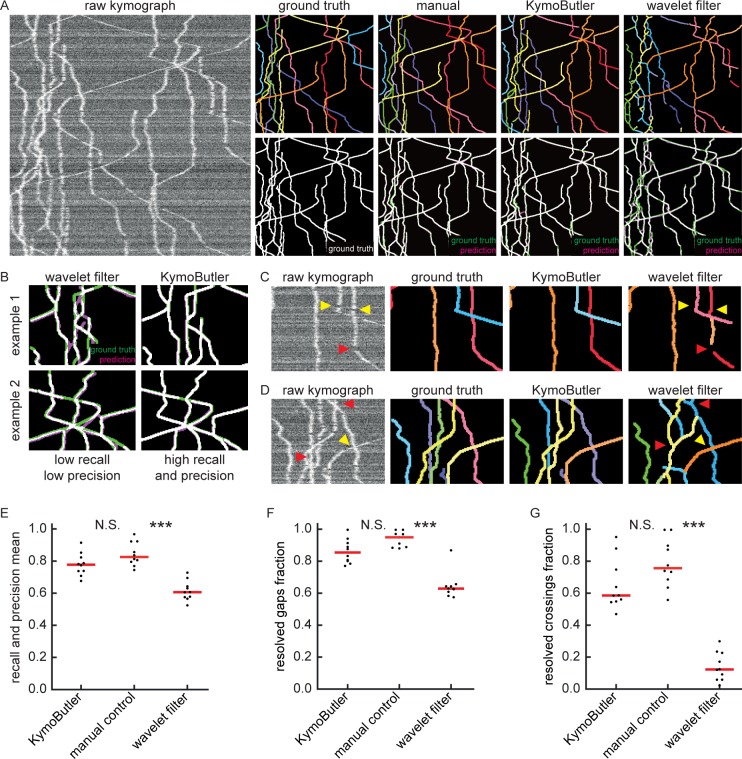
Benchmark of KymoButler against complex bidirectional synthetic data.(A) Example synthetic kymograph and its corresponding ground truth, manual control, the prediction by KymoButler, and the prediction via wavelet coefficient filtering. The top row depicts individual tracks in different colours and the bottom row shows the prediction overlay (magenta) with the ground truth (green) for all approaches. Discrepancies are highlighted in magenta (false positive) and green (false negative), while the match of ground truth and prediction appears white. (B) Example recall and precision of KymoButler and wavelet filtering. While KymoButler shows high recall and high precision, the wavelet filter approach yields significant deviations from the ground truth (green and magenta pixels). (C) Synthetic kymograph region with three artificial gaps highlighted (arrow heads). While KymoButler efficiently connects tracks over gaps, the wavelet filter is unable to do so and breaks up those tracks into segments (red arrow heads). The yellow arrow heads depict correct gap bridging events. (D) A synthetic kymograph with several line crossings. While KymoButler efficiently resolved all crossings, that is lines that cross other lines are not broken up into segments, the wavelet filter only resolves one crossing correctly (yellow arrow head). (E) The geometric means of track recall and track precision (track F1 score) for KymoButler, manual control, and the wavelet filter. Each dot represents the average F1 score of one synthetic kymograph (p=8⋅10-5, Kruskal-Wallis Test, Tukey post-hoc: manual vs KymoButler p=0.7, manual vs wavelet filtering p=10-4). (F) Quantification of gap performance for KymoButler, manual annotation, and wavelet filter (p=3⋅10-4, Kruskal-Wallis Test, Tukey post-hoc: manual vs KymoButler p=0.4, manual vs wavelet filtering p=2⋅10-4). (G) The fraction of resolved crossings for KymoButler, manual control, and the wavelet filter (p=3⋅10-5, Kruskal-Wallis Test, Tukey post-hoc: manual vs KymoButler p=0.4, manual vs wavelet filtering p=2⋅10-5). KymoButler identifies tracks in complex kymographs as precisely as manual annotation by an expert.10.7554/eLife.42288.016Figure 3—source data 1.Table of presented data.A CSV file that contains: the average track F1 score, the average gap score, and the average crossing score for each bidirectional synthetic kymograph.10.7554/eLife.42288.017Figure 3—source data 2.Synthetic kymographs and movies.A ZIP file containing all analysed synthetic bidirectional movies, their kymographs, and manually annotated ImageJ rois.